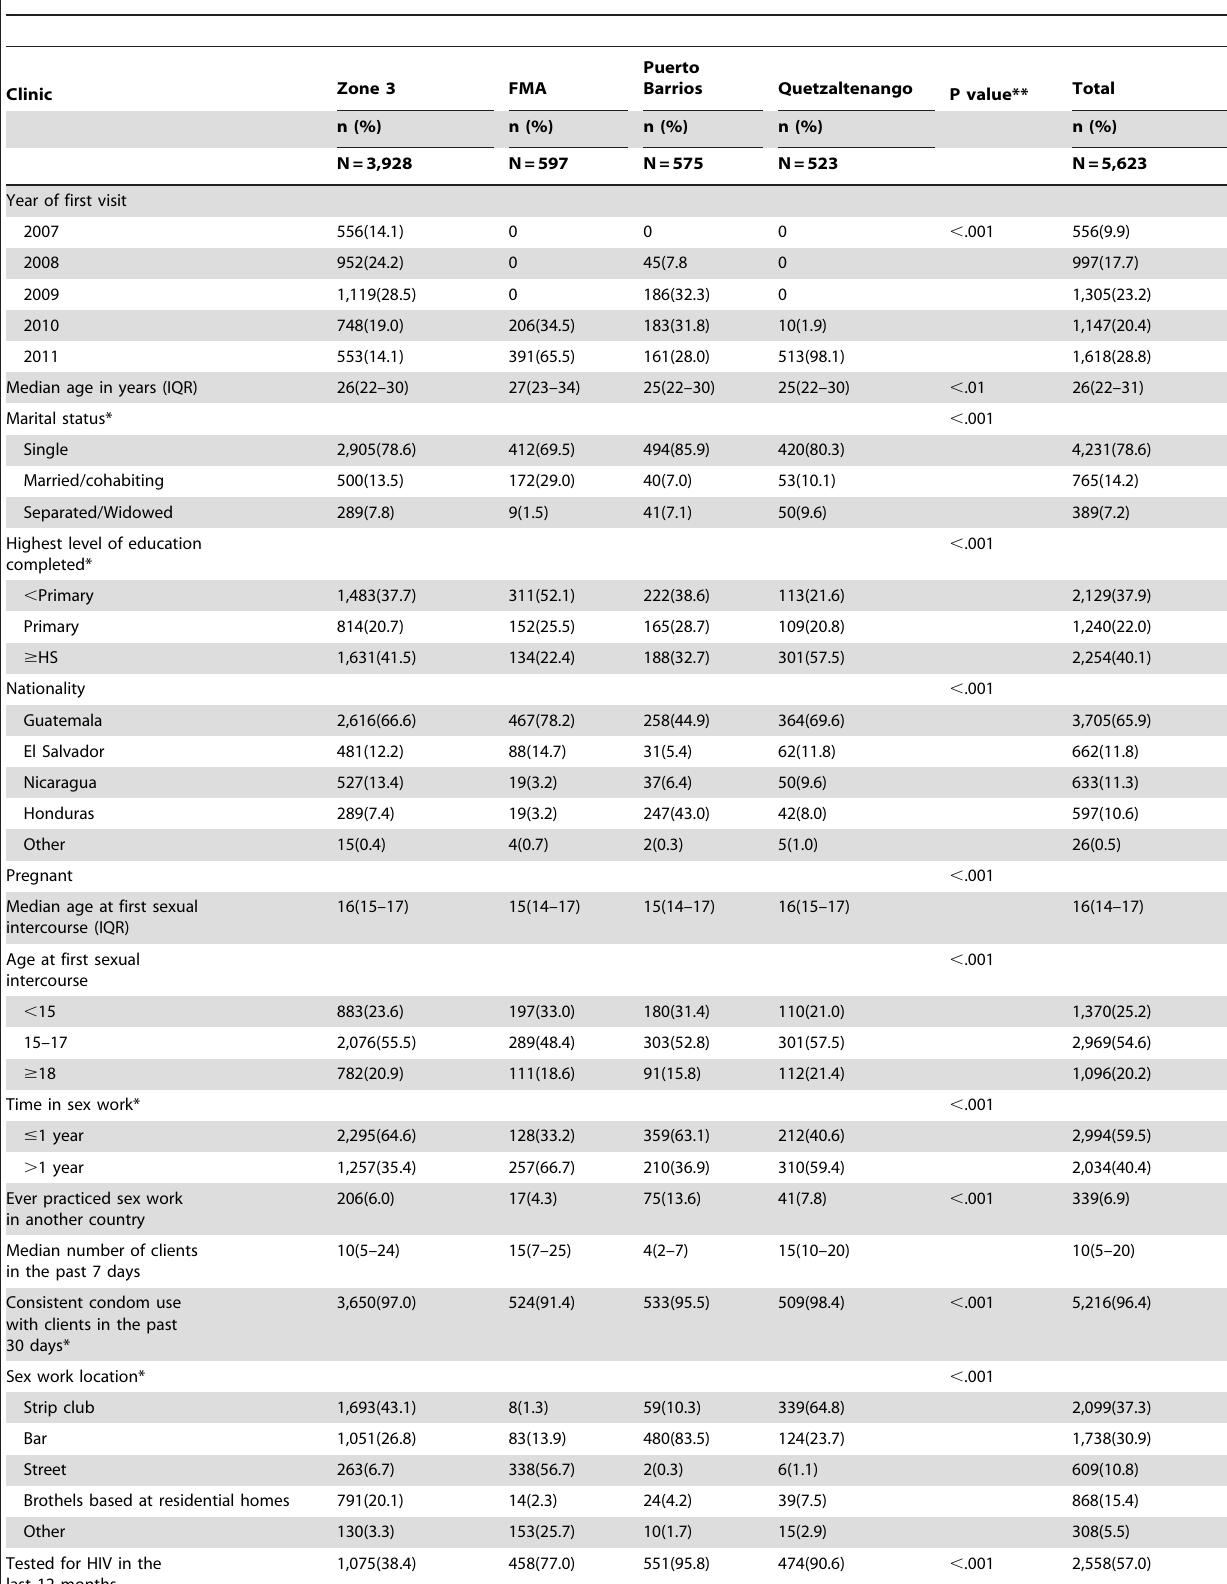
Table 1. Sociodemographic and behavioral characteristics of FSW attending VICITS clinics for the first time by clinic, Guatemala, 2007–2011 (N